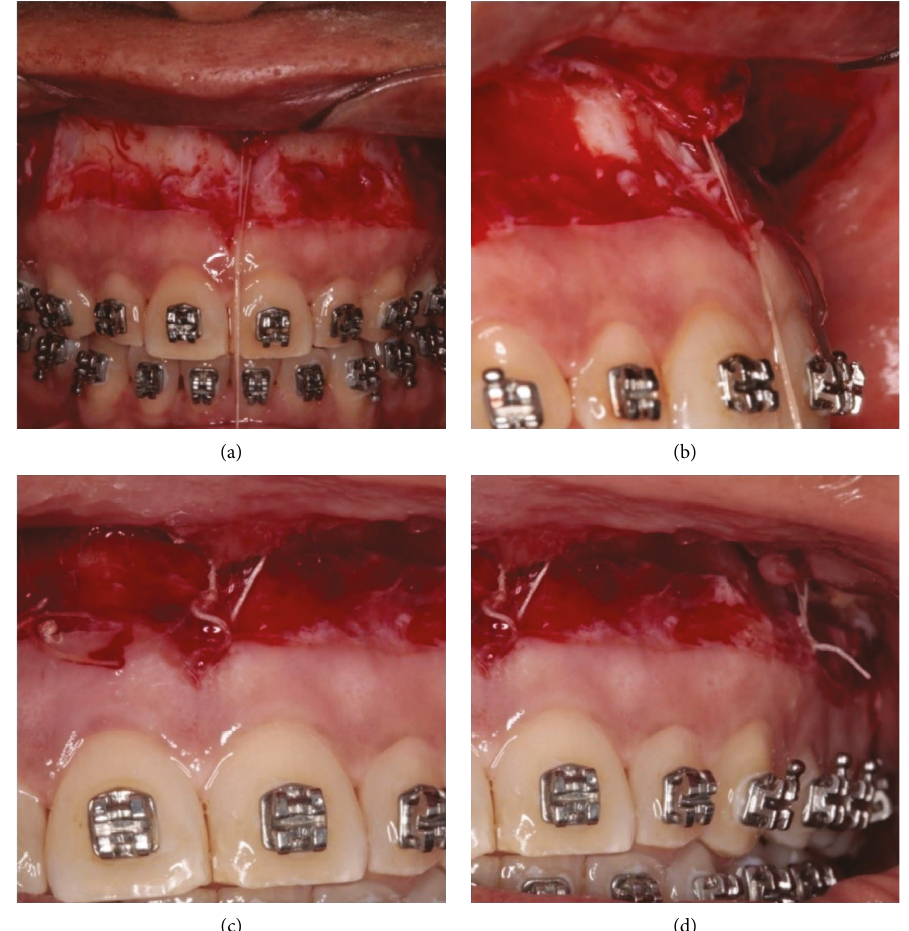
Figure 4: First suture with polyglactin at the medium line: (a) front view and (b) side view. Muscle stabilization: (c) front part and (d) back part.